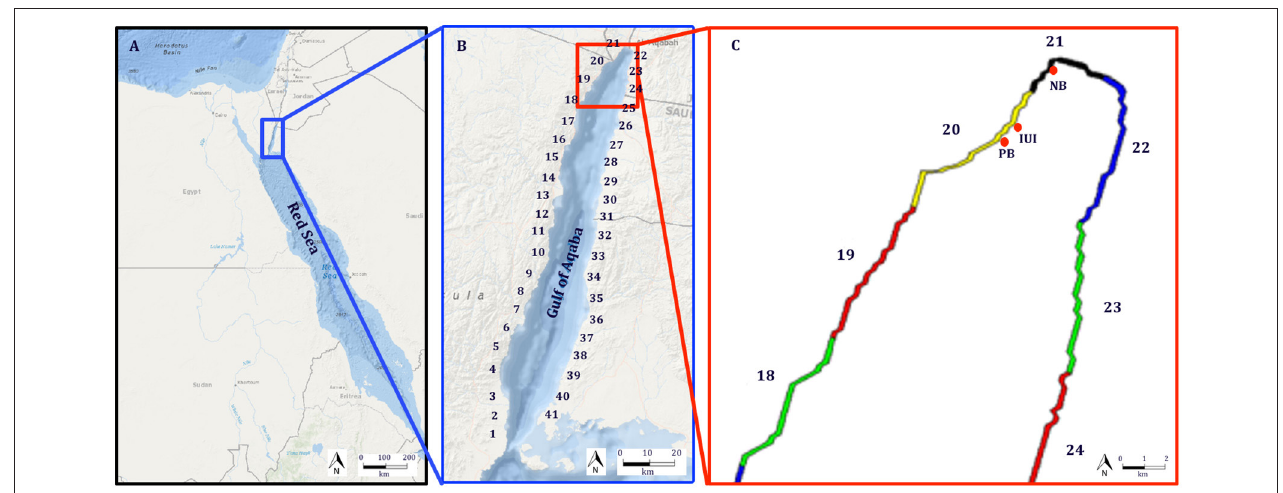
FIGURE 1 | Study area: (A) The Red Sea, and (B) The Gulf of Aqaba (GoA). Numbers in (B) represents the 41 reef polygons which are used in the biophysical model. (C) Cohort recruitment sites in the northern GoA: Princess Beach (PB), Inter-University Institute (IUI), and the North Beach